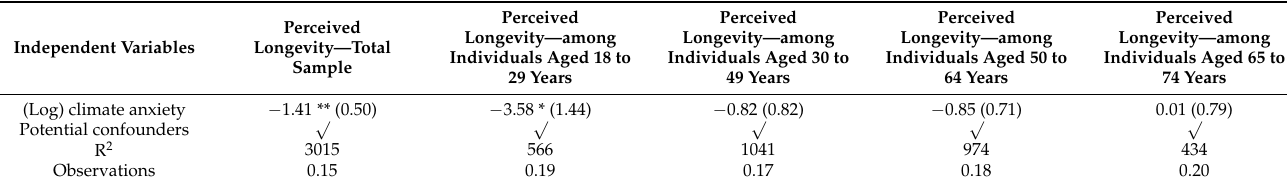
Table 2. Climate anxiety and perceived longevity. Results of linear-log